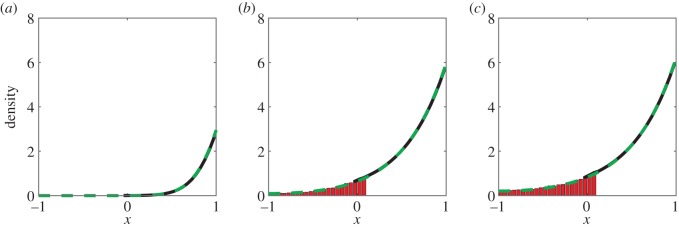
Averaged simulations of the morphogen gradient system with the hybrid algorithm (using equation (3.5) in Ωp and stochastic simulations of the reaction scheme in Ωc) compared to the analytical solution of (3.5). Initially the domain is empty. Simulations are performed up to t = 20 and averaged over 100 repeats with parameters D = 0.05, μ = 0.2, J = 125, h = 0.05, Δxp = 0.01. Panels (a), (b) and (c) show the particle density at t = 1, t = 10 and t = 20, respectively. Figure descriptions are as for figure 2. (Online version in colour.)